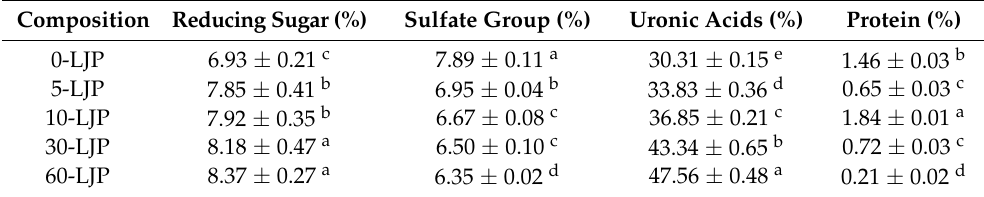
Table 1. Chemical components of